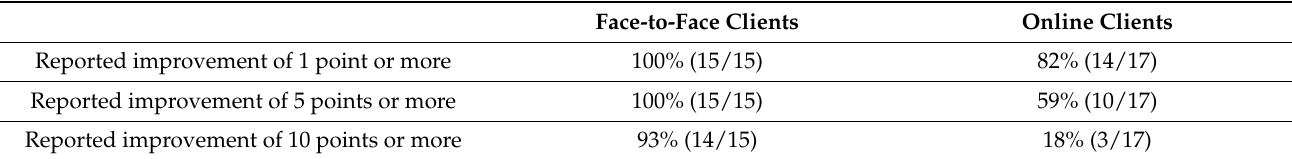
Table 4. Reported improvements for face-to-face and online clients for Outcome 2: Self-confidence.